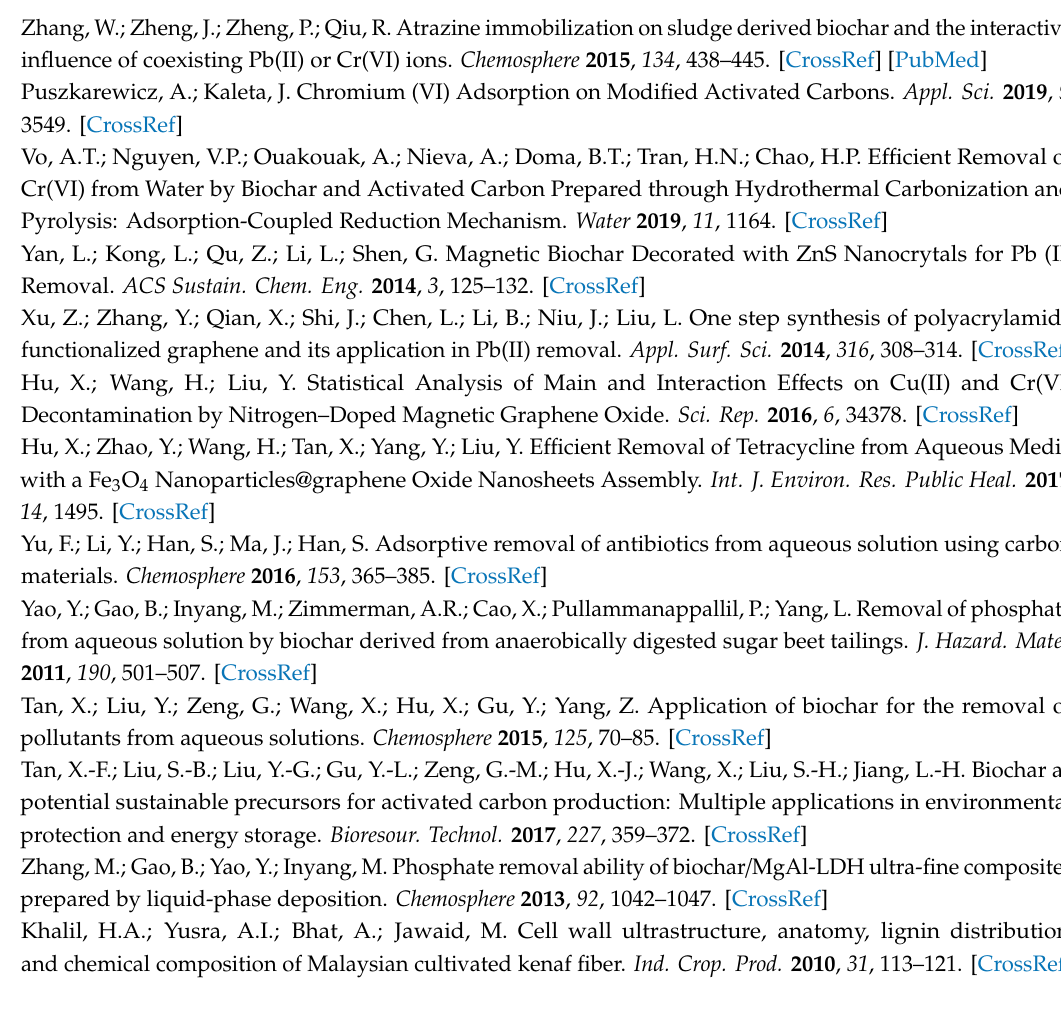
Table S1. Experimental design matrix of the 2 5 − 1 FFD for Cr(VI) adsorption onto CKB. Figure S1. Reuse experiment of CKB for three cycles. Figure S2. Cr(VI) removal onto CKB under various experimental conditions designed by 2 5-1 FFD. Figure S3. Identification of main factors and interaction factors on Cr(VI) adsorption by CKB. Figure S4. Interaction e ff ects plot for Cr(VI) decontamination. Figure S5. Cr 2p XPS spectra of CKB after